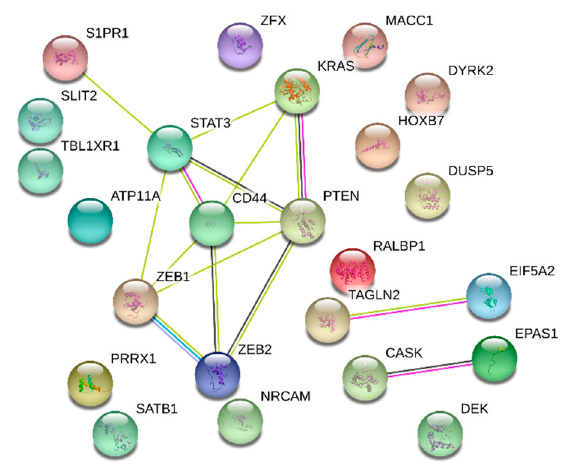
Figure 6. PPI network for the 24 overlapping prognosis genes. There were 13 genes which can been used to predict patients survival. The remaining genes worked in pairs or in groups to predict the prognosis.